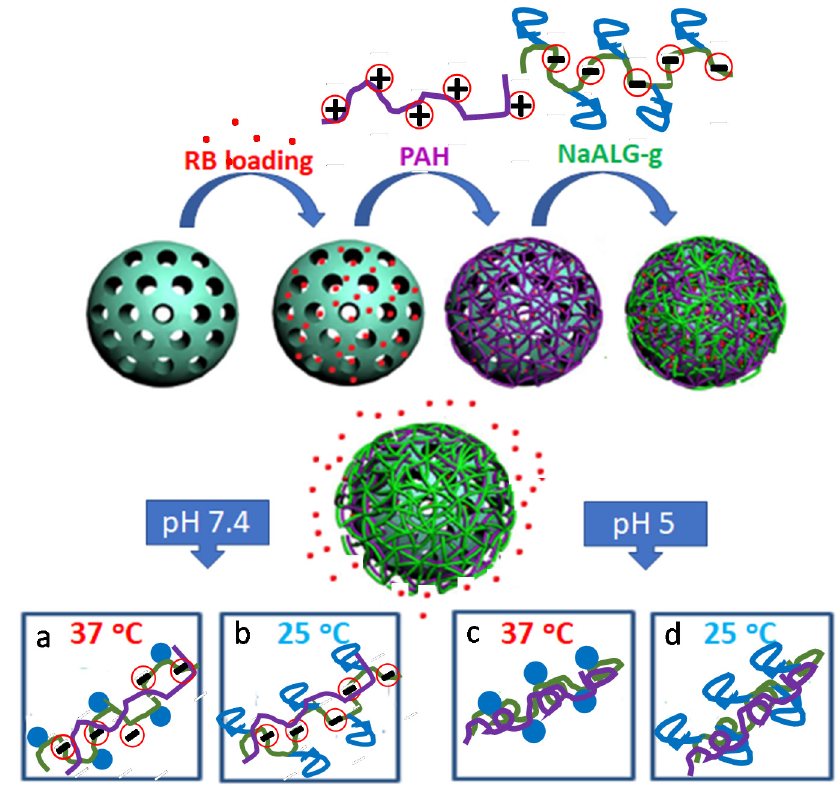
Scheme 2. Schematic representation of RB loaded in MSN and LbL (single bilayer) hNP formation along with its membrane structure at various pH/temperature conditions during RB release: open structure due to the excess negative charges of Alginate with side chains adopting either globule conformation ( a ) or coil conformation ( b ); closed structure due to charge compensation, with side chains either globule conformation ( c ) or coil conformation ( d ). (PAH purple, NaALG green, PNIPAM blue). For clarity, charges and grafting chains of Alginate at the surface of MNP have been omitted.